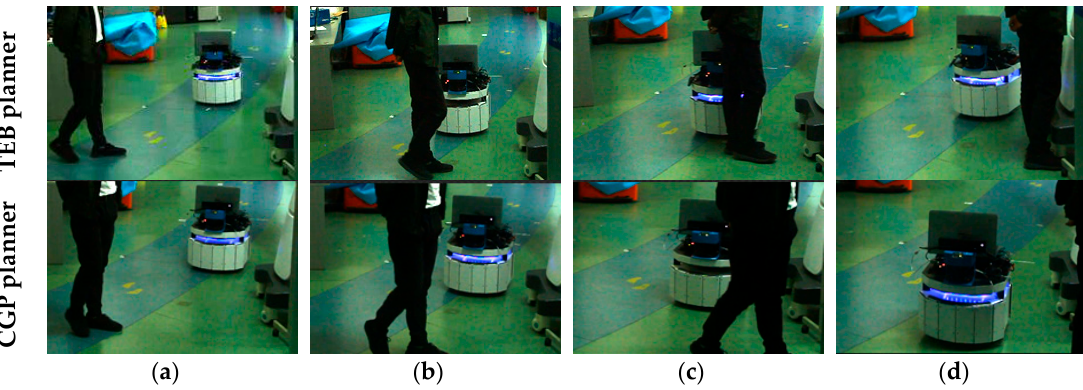
Figure 9. The robot’s navigation process of avoiding one pedestrian with TEB and CGP planners: ( a ) the robot selects the trajectory of G f ( p ); ( b , c , d ) a sharp return happens with TEB planner, however, no sharp return happens with CGP planner.